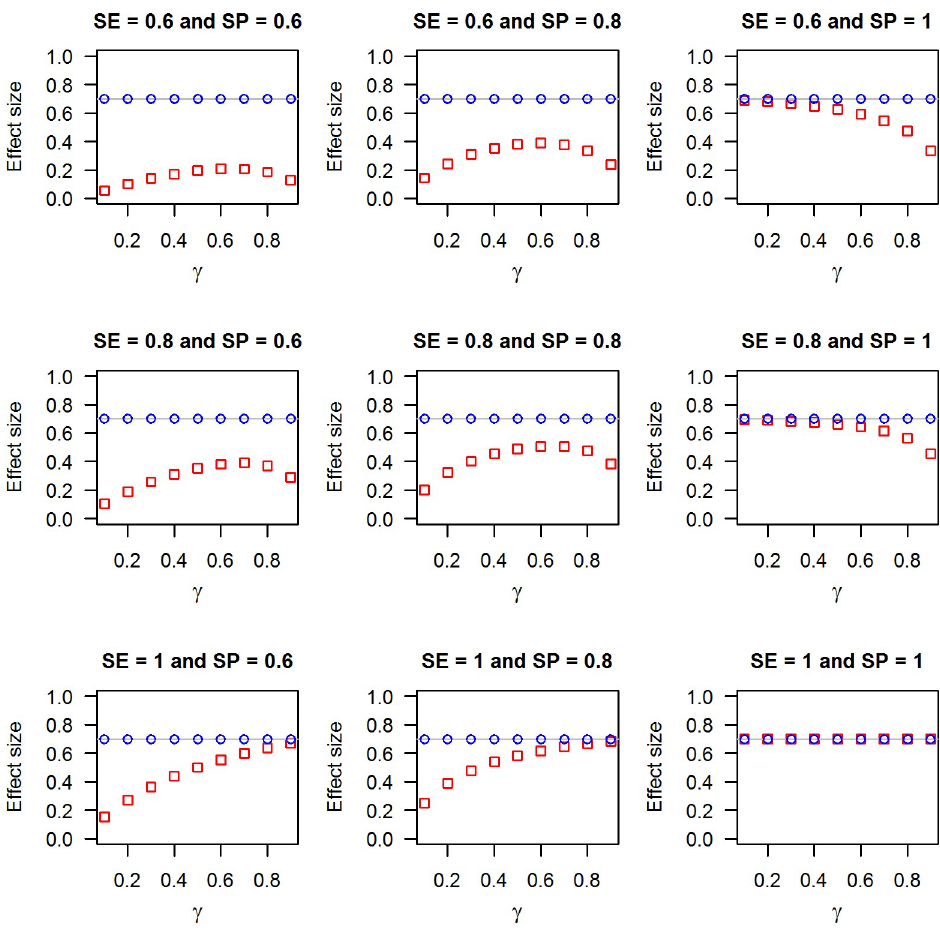
Fig 2. Effect size measured by the estimands (1 − p 1 / p 0 ) (red squares) and VE (blue circles) under non-differential exposure misclassification. Data points were calculated using Eqs (2B), (3B) and (6), π 1 = 0.045, π 0 = 0.15 and γ , SE and SP as given in the panels. The horizontal grey line marks the true vaccine